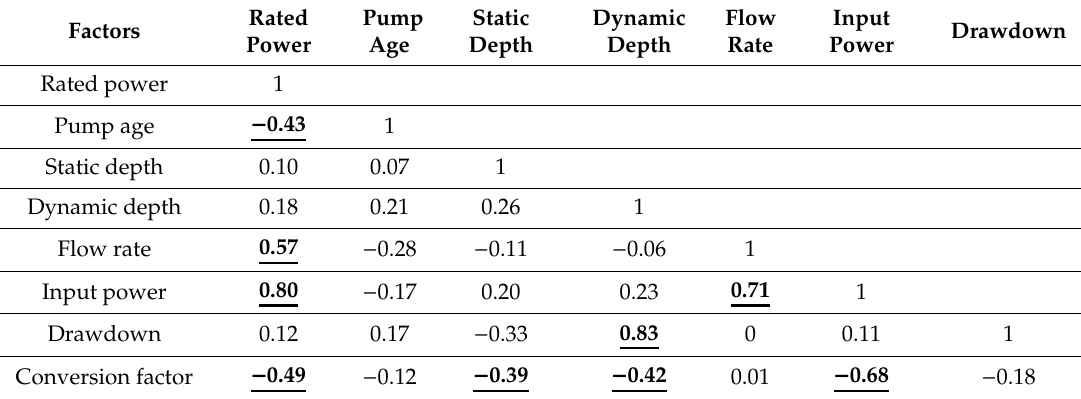
Table 1. Correlation matrix between conversion factor and other factors. Statistically significant correlations ( p < 0.05) are in bold and